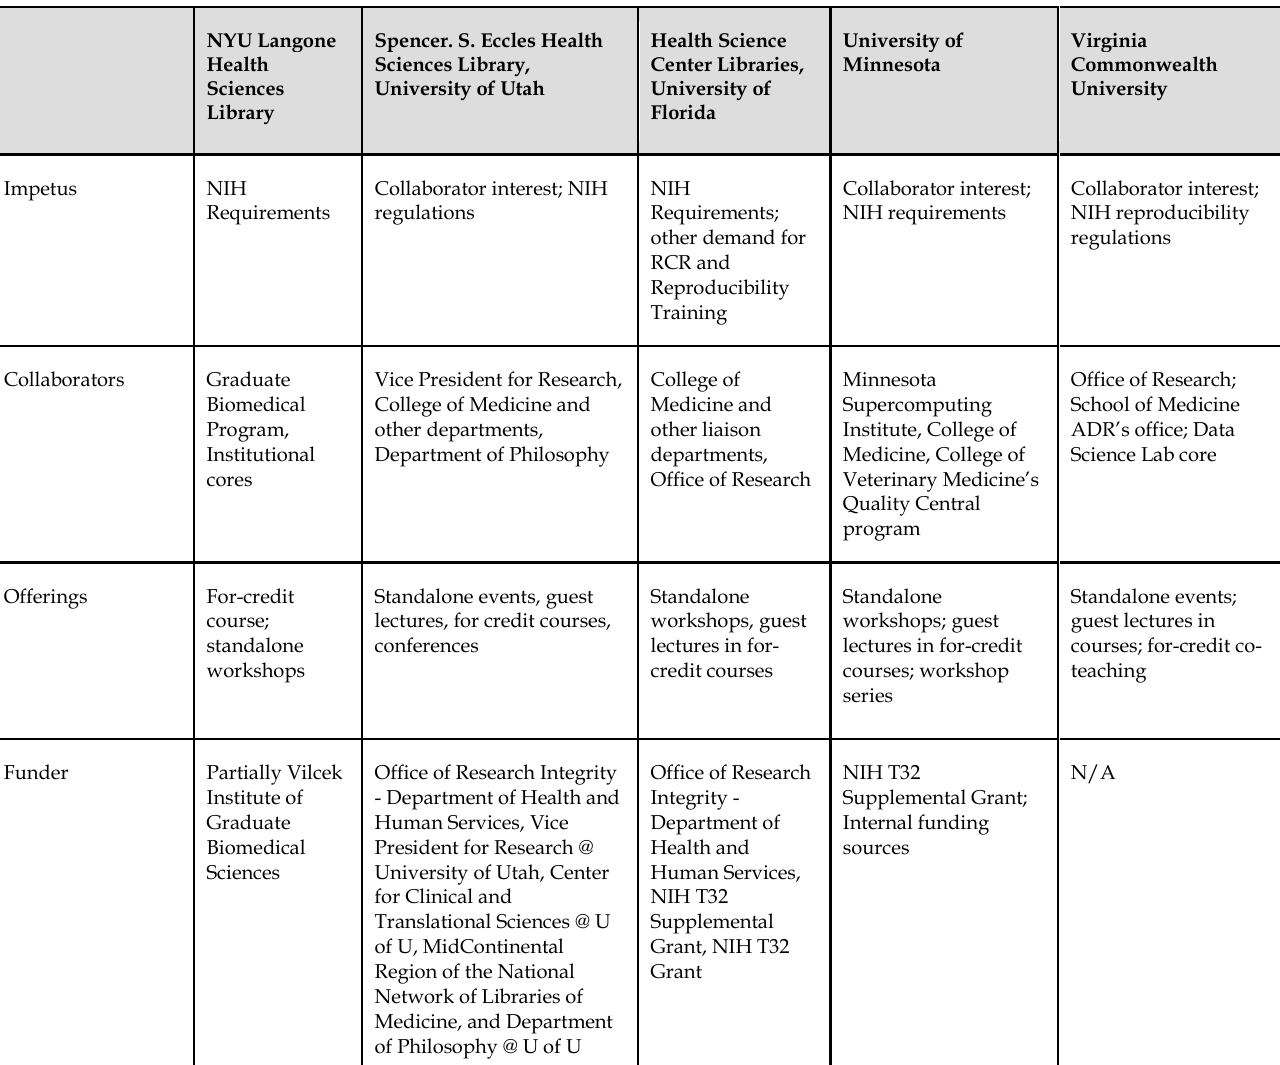
Table 2 Summary of Rigor and Reproducibility Training at Five Academic Medical